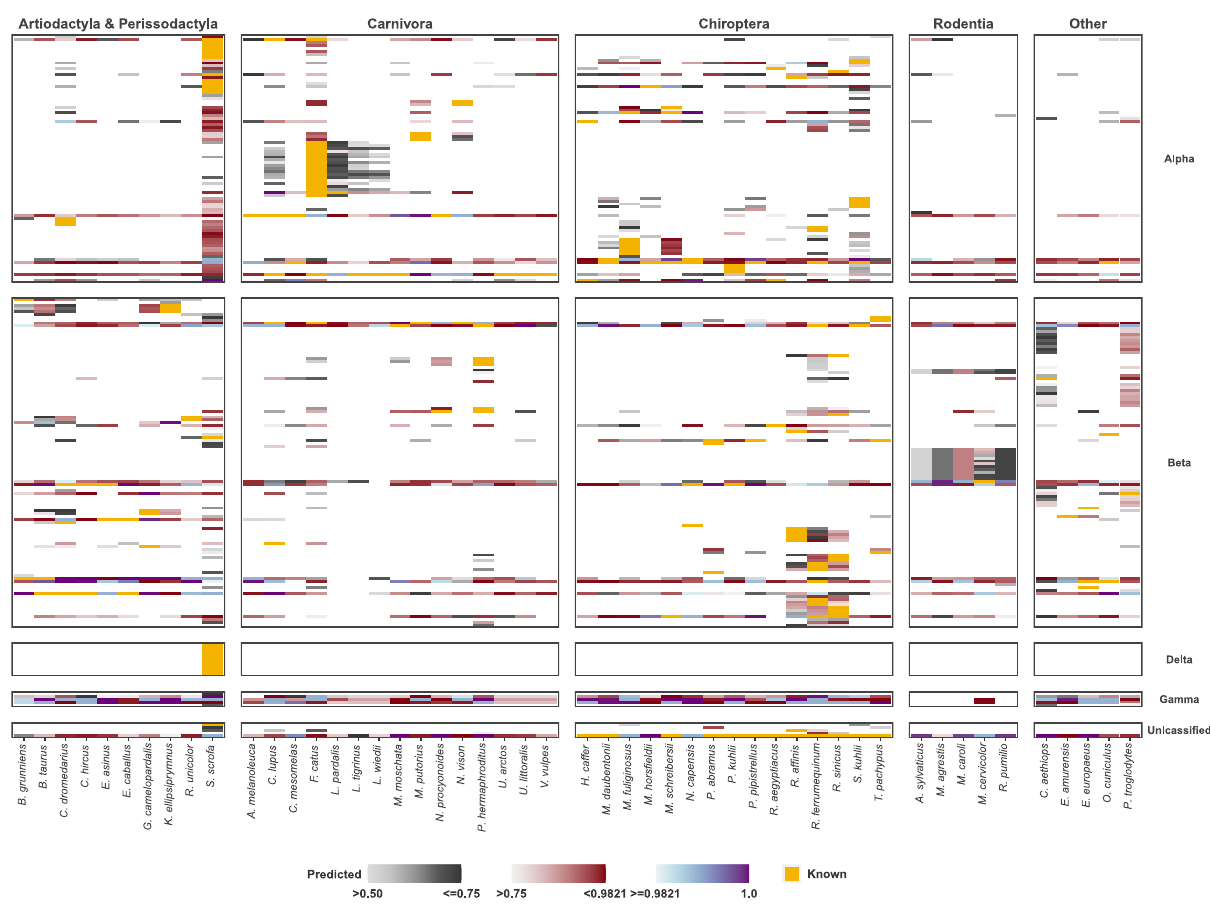
Fig. 2 Observed and predicted mammalian hosts for coronaviruses. Columns present mammalian hosts in four categories: Artiodactyla and Perissodactyla (top 10 hosts by number of predicted coronaviruses that could be found in each host), Carnivora (top 15 hosts), Chiroptera (top 15 hosts), Rodentia (top 5 hosts) and others (top 5 hosts). Rows present viruses ordered into fi ve taxonomic groups: alphacoronaviruses, betacoronaviruses, deltacoronaviruses, gammacoronaviruses and unclassi fi ed Coronavirinae. Yellow cells represent observed associations between the host and the coronavirus. Grey/red/blue cells indicate the probability of predicted associations in three increasing probability ranges. White cells indicate no known or predicted association between host and virus (beneath cut-off probability of 0.5). Supplementary Data 4 lists full results. These results exclude humans and lab rodents. Supplementary Data 5 lists predictions for humans. Supplementary Fig. 15 illustrates full results including these